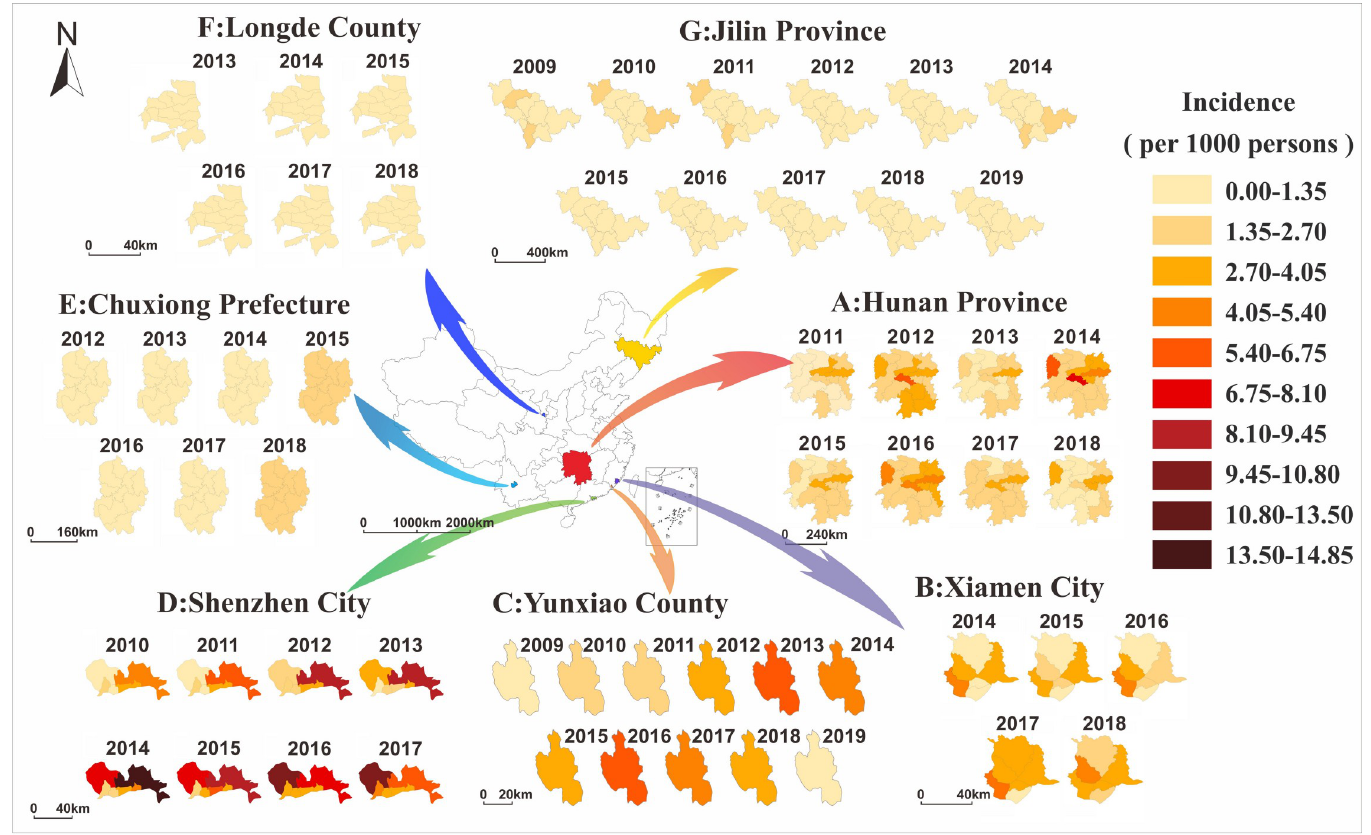
Fig 4. The temporal and spatial distribution of HFMD in Hunan Province, Jilin Province, Shenzhen City, Xiamen City, Chuxiong Prefecture, Yunxiao County, and Longde County. The map depicted in this figure was taken from Wikimedia Commons (http://commons.wikimedia.org/wiki/Main_Page). (A: Hunan Province; B: Xiamen City; C: Yunxiao County; D: Shenzhen City; E: Chuxiong Prefecture; F: Longde County; G: Jilin